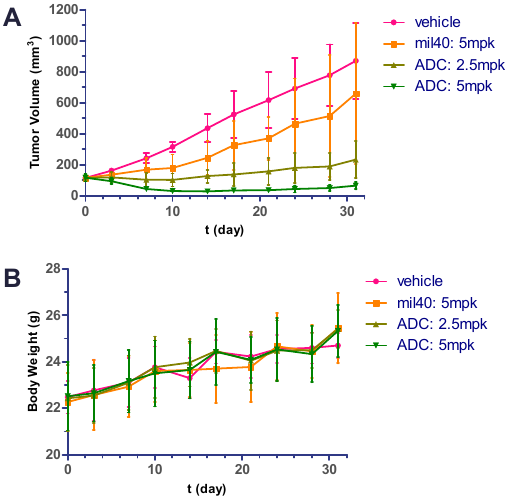
Figure 8. Xenograft studies of the ADC (mil40-6). Nude mice were implanted subcutaneously with NCI-N87 cells. When the tumors reached ~ 120 mm 3 , the animals were given vehicle, mil40, and ADC on: Days 0, 7, 14, and 21. Results are shown as mean ± SD, n = 6 / group. ( A ) The tumor volume of the test animals during the treatment and observation period; ( B ) changes in body weight of the mice during the observation period. To compare the di ff erence in activity between antibody and ADC, unpaired two-tailed t tests for multiple comparisons were used, and statistical analyses were performed using Prism5 for